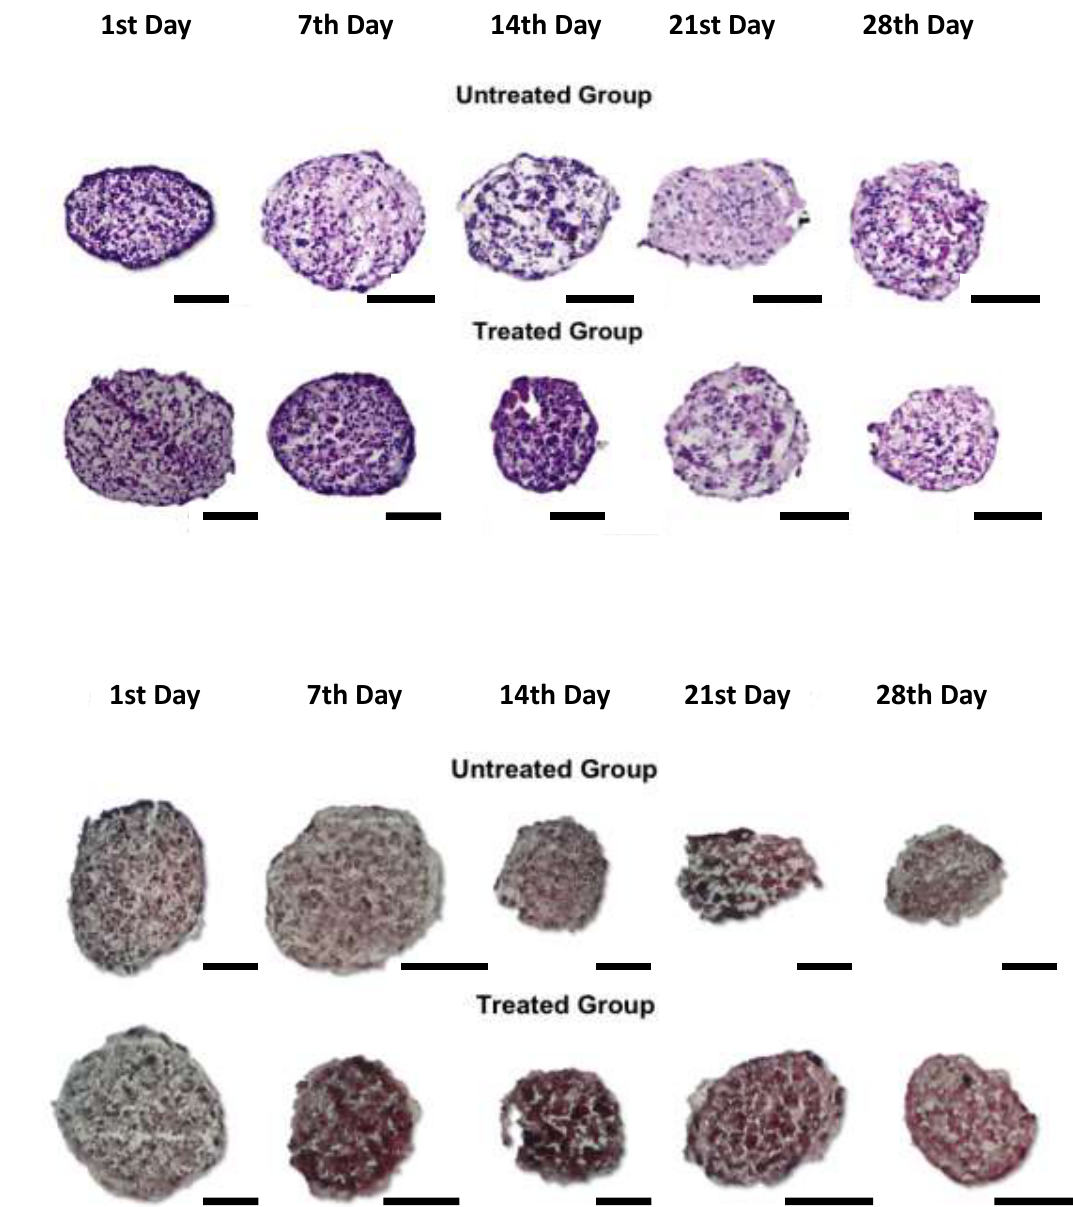
Figure 4. Photomicrographs of spheroids maintained in culture with untreated medium and treated for osteogenic induction. ( A ) 7 μm thick sections stained with HE and ( B ) 7 μm thick sections stained with Alizarin Red (aggregates collected at 1, 7, 14, 21, and 28 days counted after the formation time of 4 days and after the first day of exposure to the induction medium). Images obtained with a 20× objective. Scale bars indicate 100 µm.